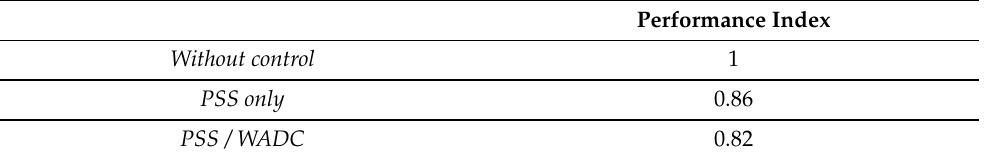
Figure 18. Frequency deviation between area 1 and area 2 for the three cases (without control, PSS only, PSS and WADC) after the tie line trip within the setup with the dynamic hardware emulator. Table 6. Normalized performance index of the three cases (without control, PSS only, PSS and WADC) for the frequency deviation between the areas within the dynamic hardware emulator